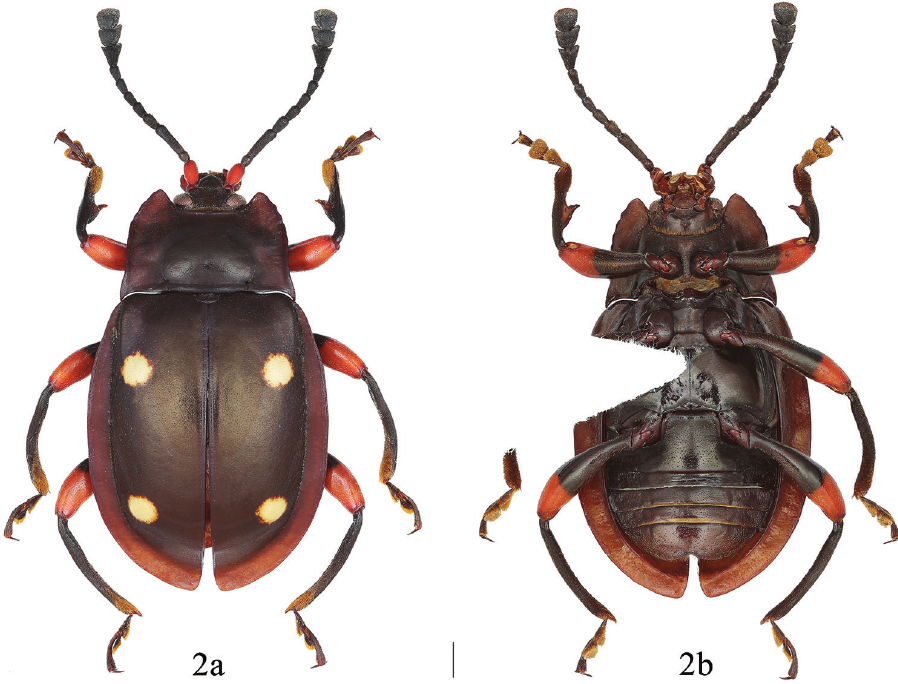
Figure 2. Dorsal and ventral habitus of E. qiujianyuei sp. n. male. a dorsal view b ventral view. Scale bar 1